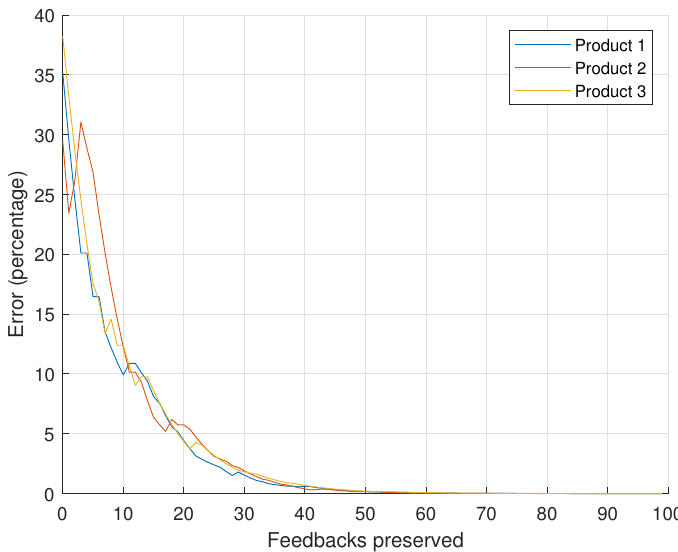
Figure 9. Error percentage for varying